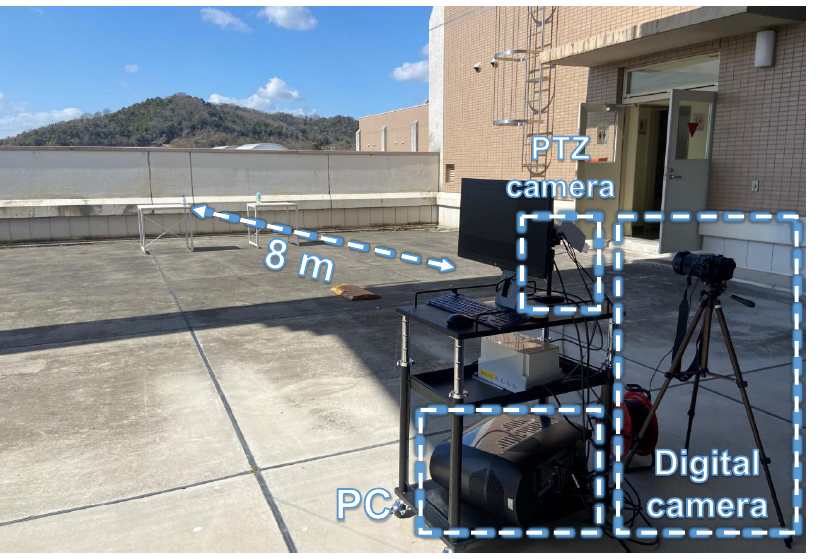
Figure 9. Experimental environment used for tracking multiple moving objects in an outdoor scene.